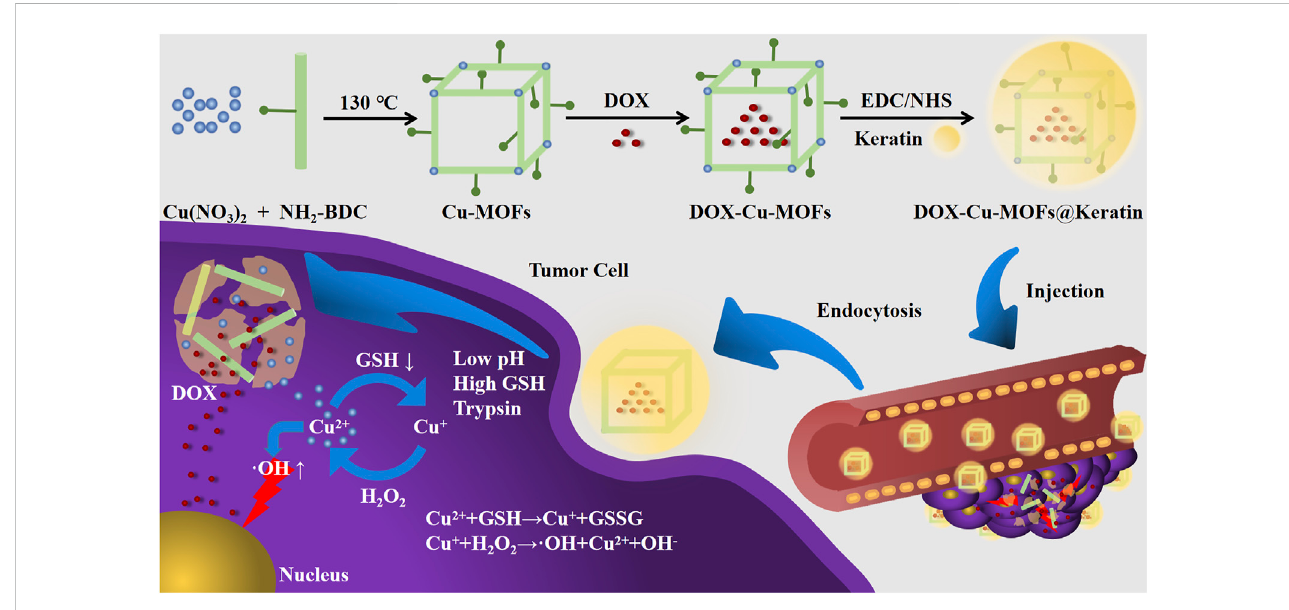
FIGURE 1 Schematic diagram of the preparation and working fl owchart of